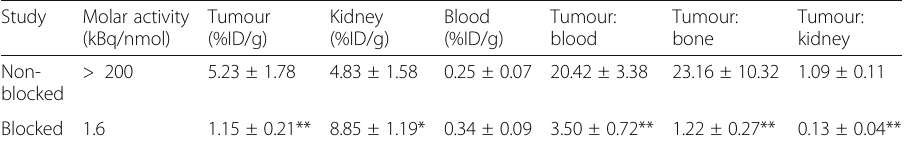
Table 5 Summary of in vivo biodistribution studies of [ 225 Ac]Ac-CCZ01048 at 2 h post-injection. Statistical analysis between non-blocked and blocked experiments was performed using the Student ’ s t -test (* p < 0.05; ** p < 0.005; n = 4 for each animal